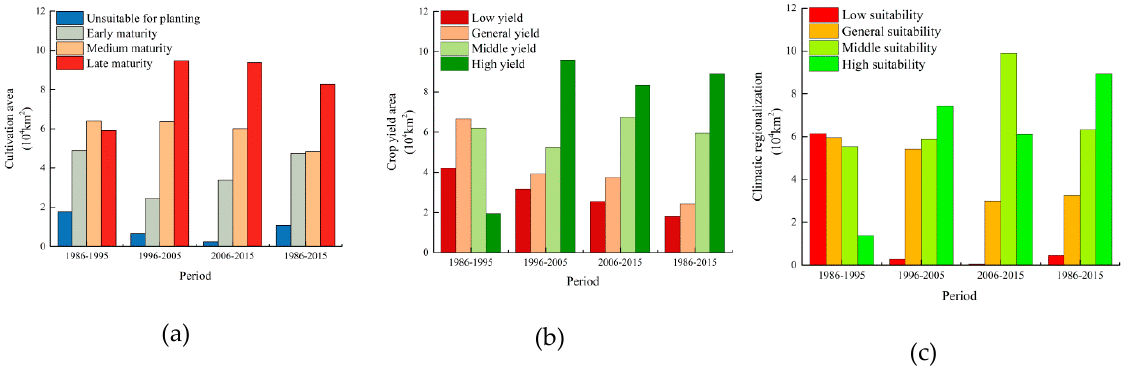
Figure 9. Area change for cultivar patterns ( a ), crop yields ( b ), and climate suitability ( c ).